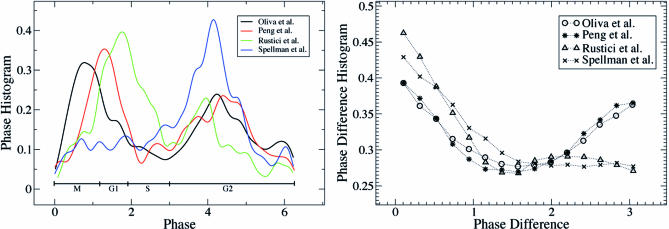
Phase Distributions (Left) and Phase Difference Distributions (Right) for Periodic Genes from the Three Independent Studies on S. pombe and from the Study on S. cerevisiae by Spellman et al. [24]On the x-axis, the phase values are given in radians between 0 and 2π and the phase differences in radians between 0 and π. The y-axis always shows the corresponding frequency distribution.